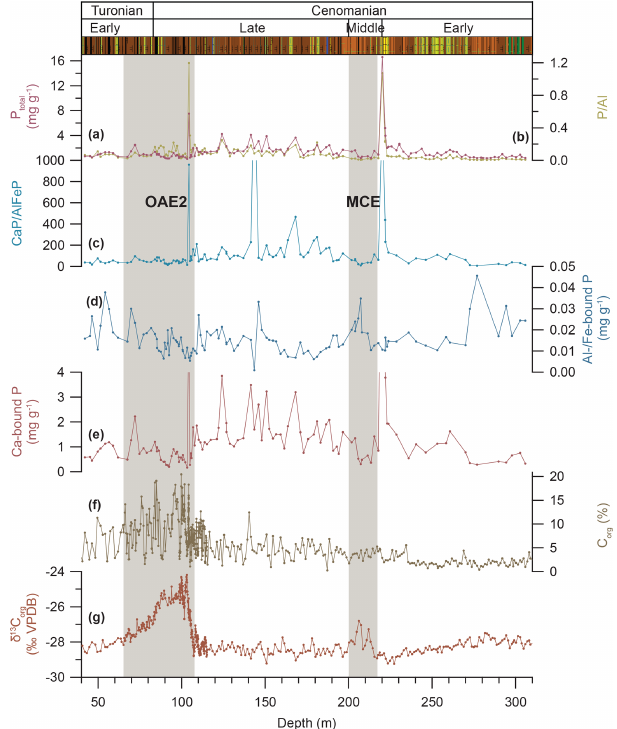
Figure 6. Phosphorus concentration and speciation in Tarfaya Basin Core SN ◦ 4. (a) Concentration of total phosphorus (P total ). (b) Ratio of total phosphorus to aluminium (P / Al) measured on bulk sediment. (c) Ratio of calcium- to aluminium- and iron- bound phosphorus (CaP / AlFeP). (d) Concentration of aluminium- and iron-bound phosphorus (Al / Fe-bound P). (e) Concentration of calcium-bound phosphorus (Ca-bound P). (f) Concentration of or- ganic carbon (C org ) and (g) δ 13 C org from Kuhnt et al. (2017) and Beil et al. (2018).